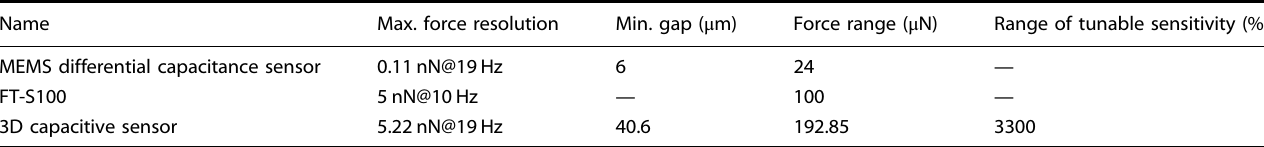
Table 2. Performance of three differential capacitance sensors by different fabrication